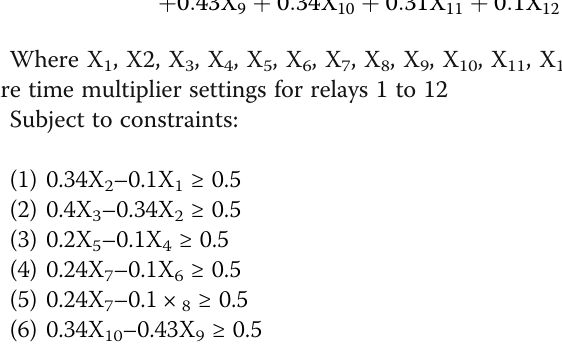
Table 2 Calculated parameters for formulation of objective function Relay Maximum Fault No Current L-L-L Fault